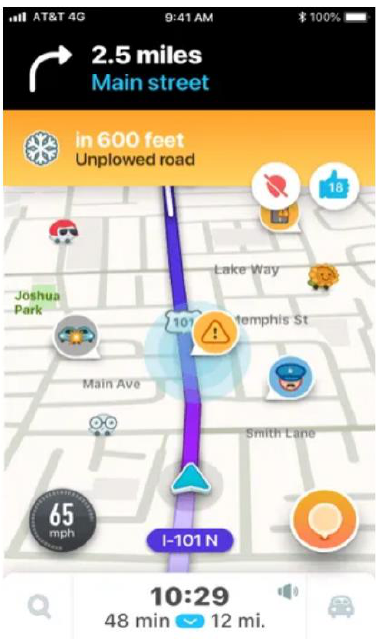
Figure 2 : Waze, instant information sharing about the route.